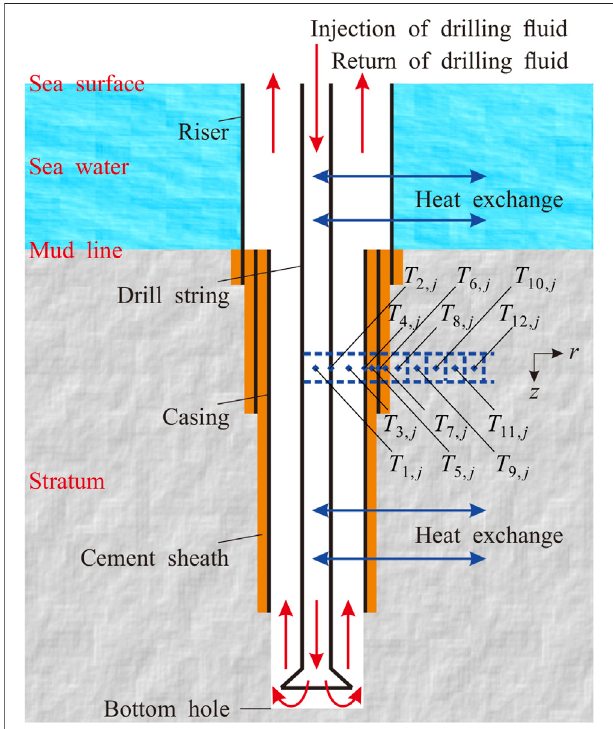
FIGURE 1 | Physical model of drilling fl uid fl ow and heat exchange in deep-water drilling.